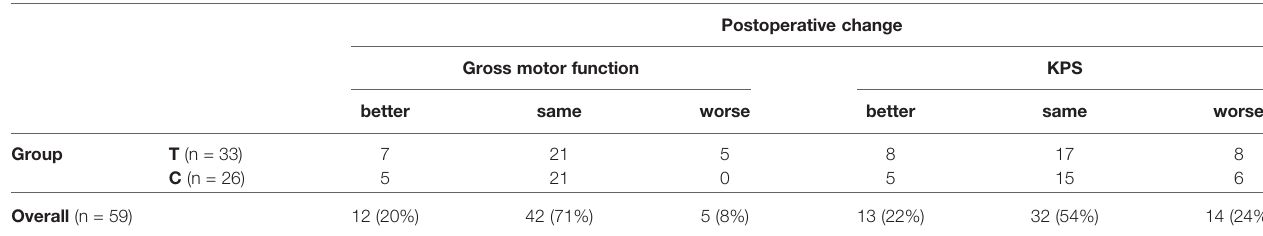
TABLE 3 | Contingency tables showing group-wise distribution of functional